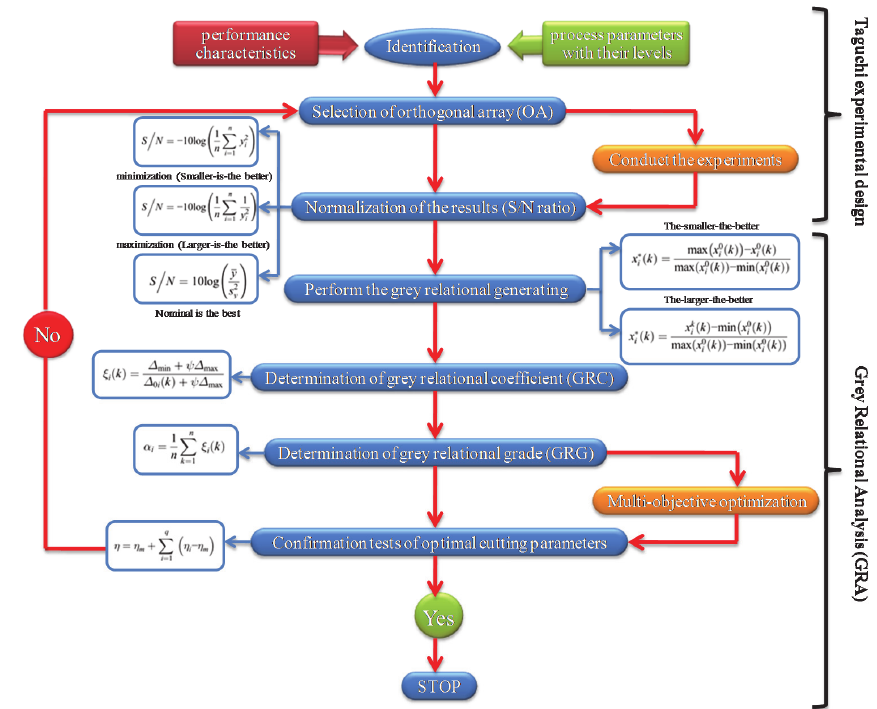
Fig. 1. Loop of multi-objective optimization of grey relational analysis (GRA) based on Taguchi experimental